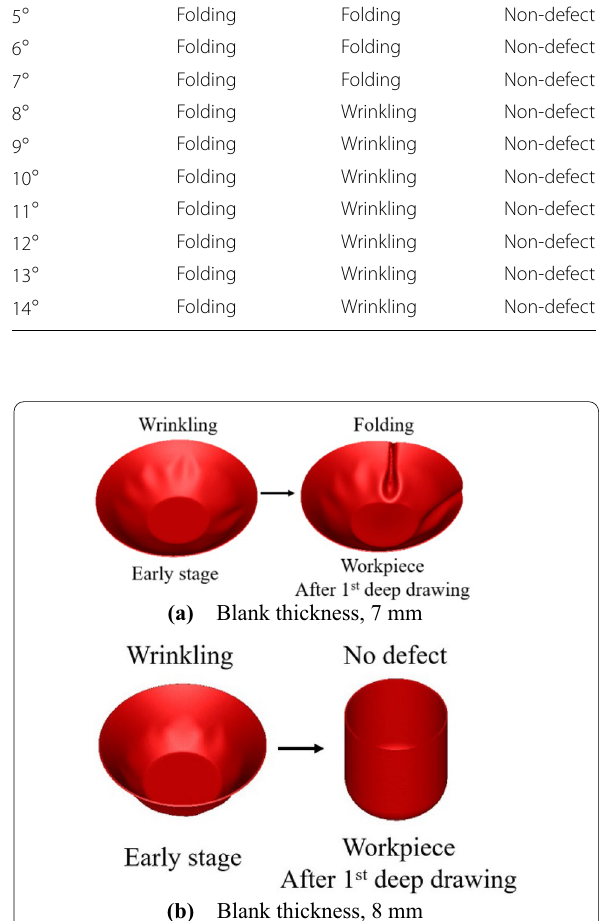
Figure 11 Onset and decrease of wrinkling and folding in case of the inflow angle of